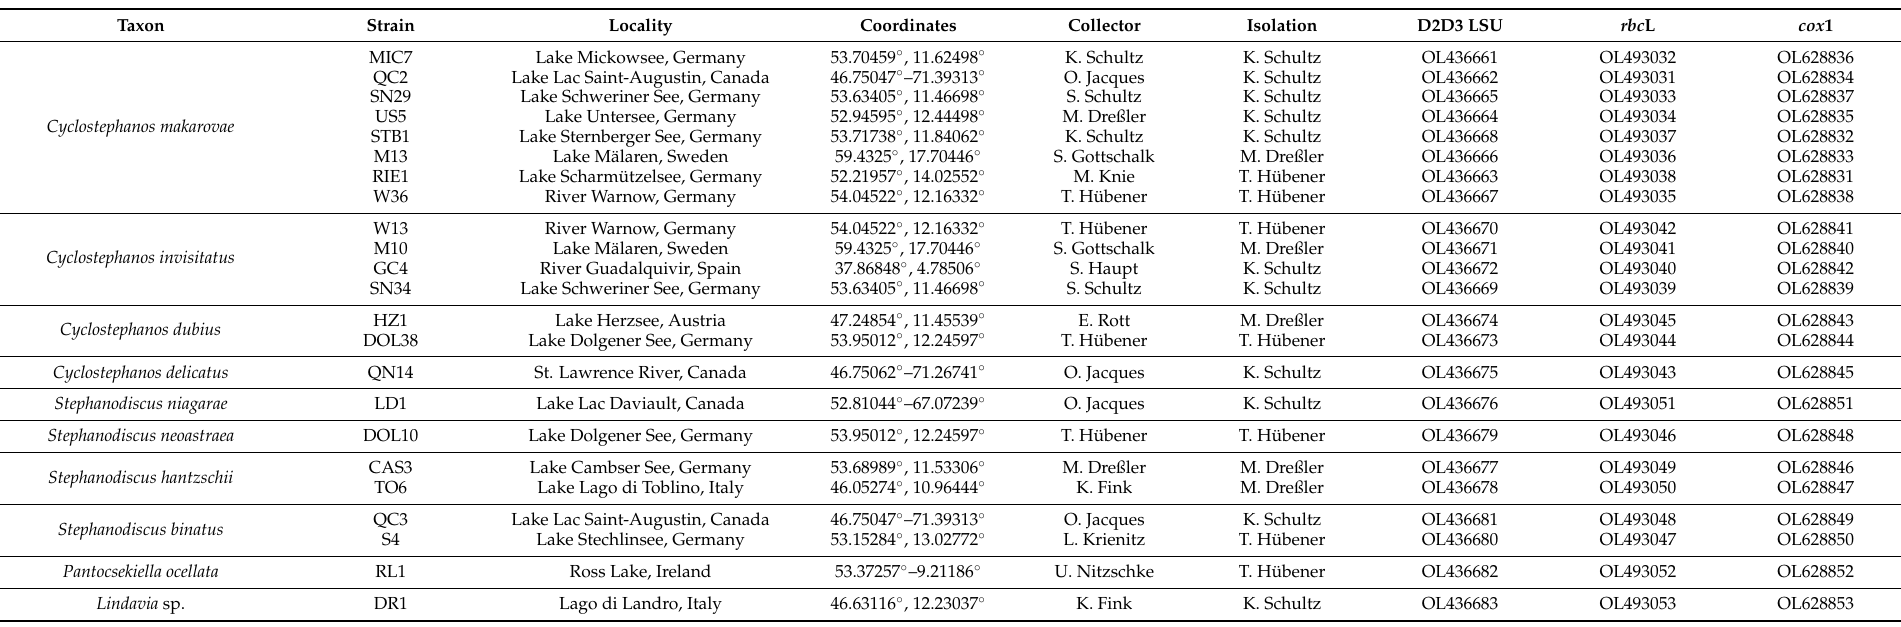
Table 1. The strains used in this study and their strain ID, localities, coordinates, collector and isolator information, and GenBank accession numbers for the respective gene